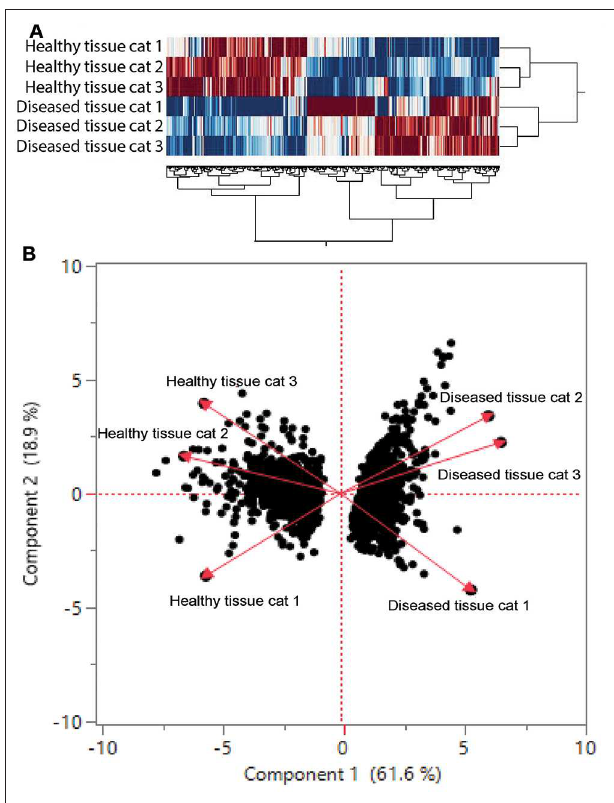
FIGURE 4 | (A) Cluster analysis of differentially regulated genes in healthy and diseased tissue from FCGS cats. Note that diseased tissues are clustering differently from healthy. (B) Principal component analysis of genes in healthy and diseased cat